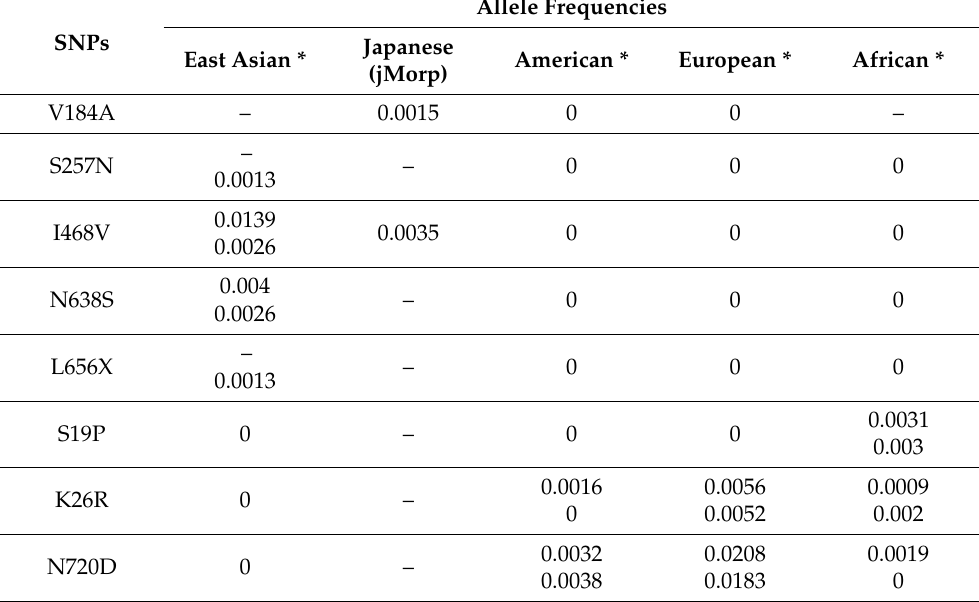
Table 1. ACE2 single-nucleotide polymorphisms (SNPs) found in different populations. Allele Frequencies SNPs Japanese American * European * African * East Asian * (jMorp) V184A – 0.0015 0 0 – – S257N – 0 0 0 0.0013 0.0139 I468V 0.0026 0.004 N638S – 0 0 0 0.0026 – L656X – 0 0 0 0.0013 0.0031 S19P 0 – 0 0 0.003 0.0016 K26R 0 – 0.0032 0.0208 0.0019 N720D 0 – 0.0038 0.0183 0 Upper row, data from gnomAD; lower row, data from the 1000 Genomes